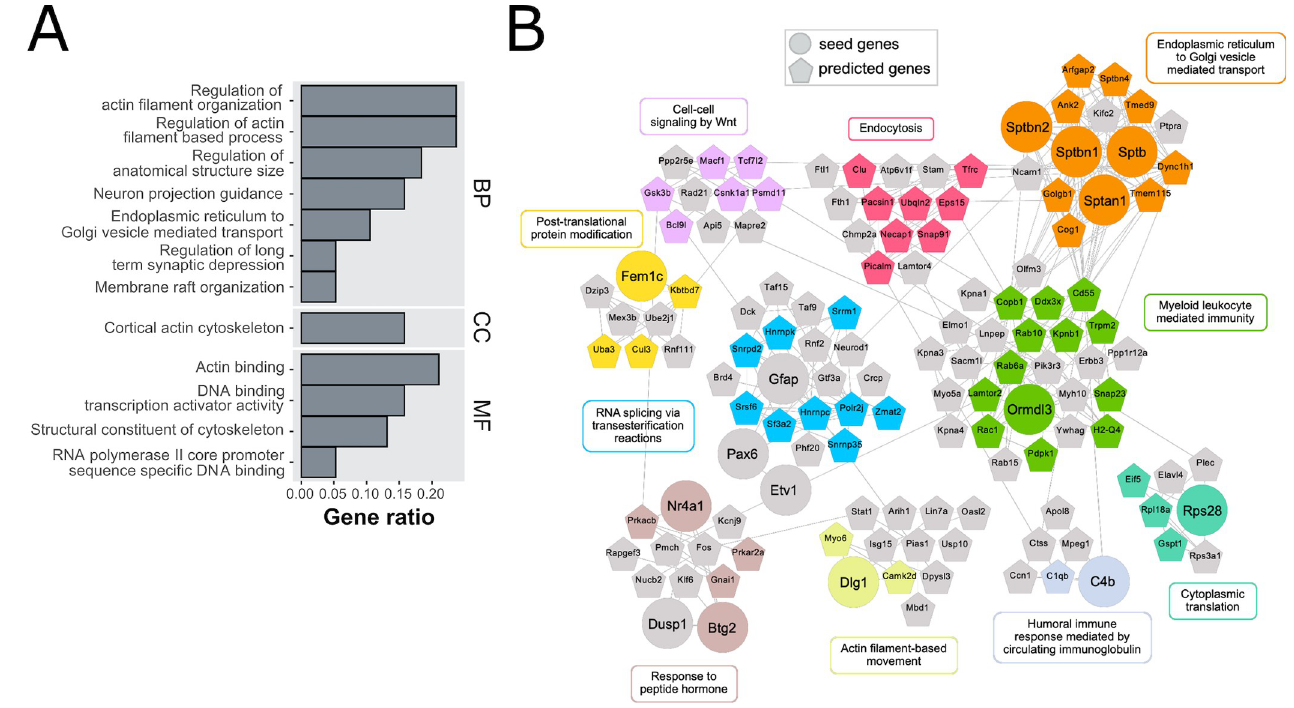
Fig 5. Changes in glutamatergic neurons (RiboTag::vGluT2-Cre). ( A ) Overrepresentation analysis of DEGs in glutamatergic neurons (vGluT2+ cells) at 10 WPI. Significantly enriched GO categories were shown for molecular function (MF), biological process (BP) and cellular component (CC) GO subsets. Most significantly enriched categories were related to cytoskeleton (e.g., regulation of actin filament organization) and synaptic function (e.g., regulation of long- term synaptic depression). X-axis is the reciprocal of gene ratio. ( B ) Visualization of disease DIAMOnD modules constructed around 15 of 33 DEGs (circles) in glutamatergic neurons. Pentagons denote genes predicted by the DIAMOnD algorithm. The module consists of 7 functionally related clusters (identified with the fast greedy modularity optimization algorithm). In each cluster, the genes annotated to the representative GO term are colored. See also S7 Fig for additional GO